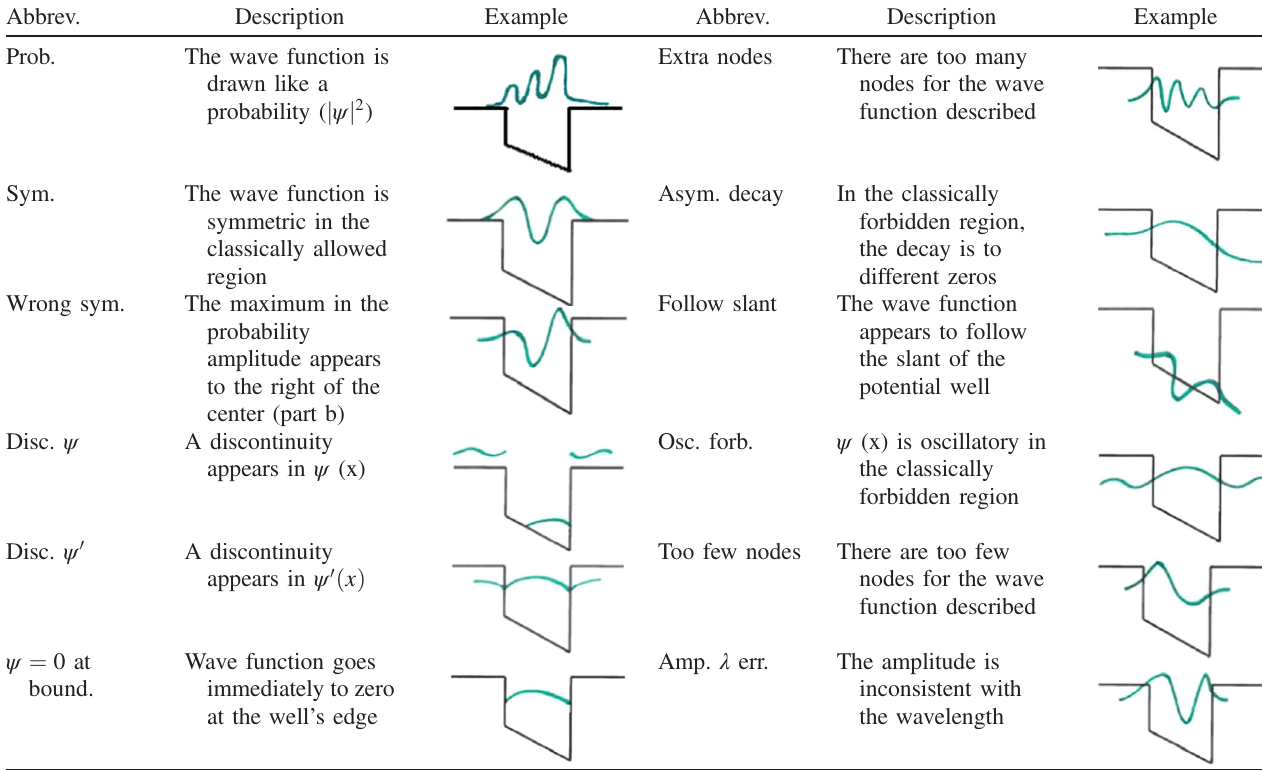
TABLE III. Common errors in drawing the wave function in the asymmetric well. Some could only be marked as errors in drawings of the 2nd excited state. Graphical representations are tracing reproductions by investigators.